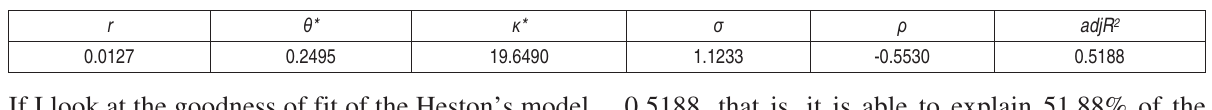
Table 4. Estimated parameters for Heston’s model and R 2 statistic